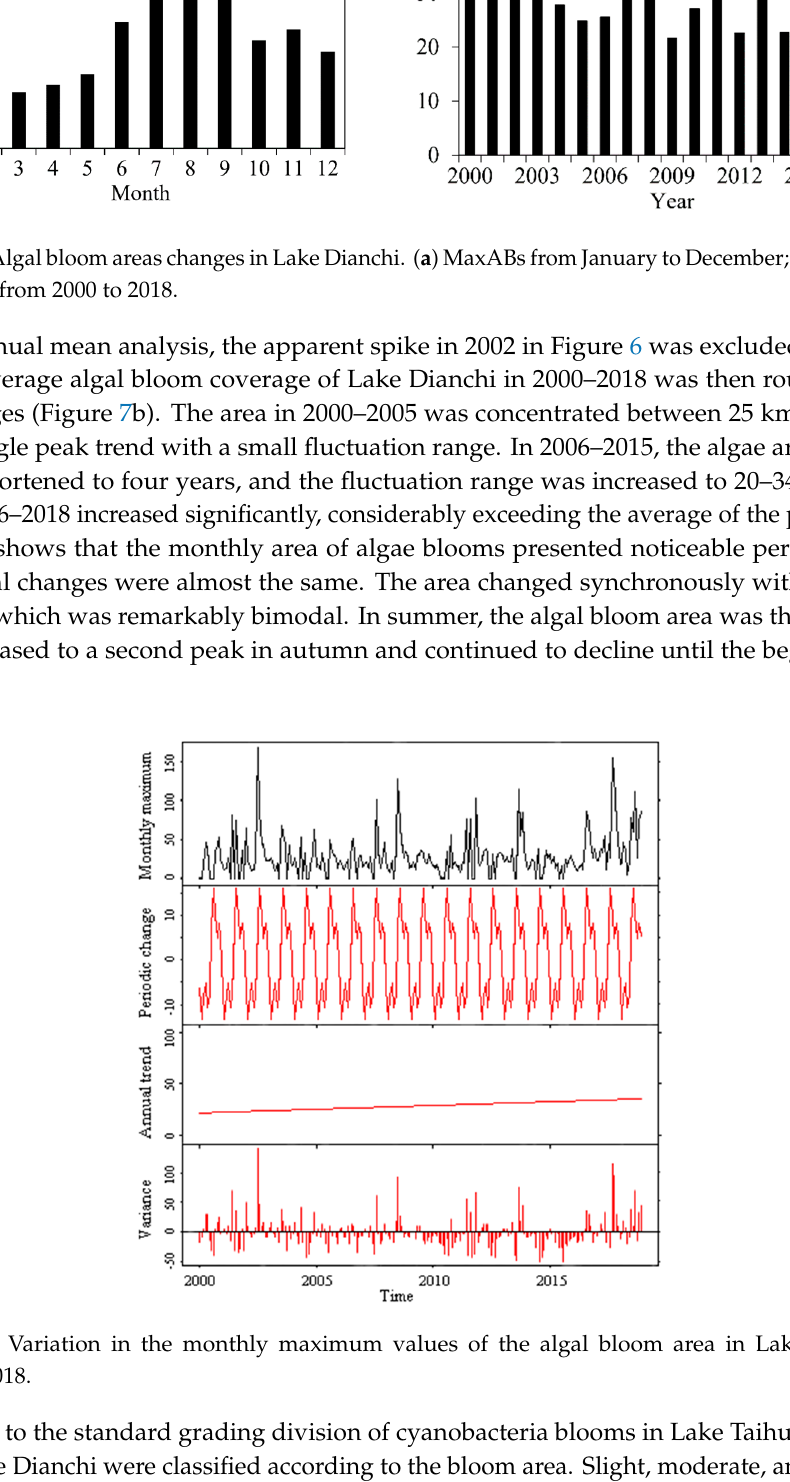
Figure 8. Variation in the monthly maximum values of the algal bloom area in Lake Dianchi for 2000- 2018.